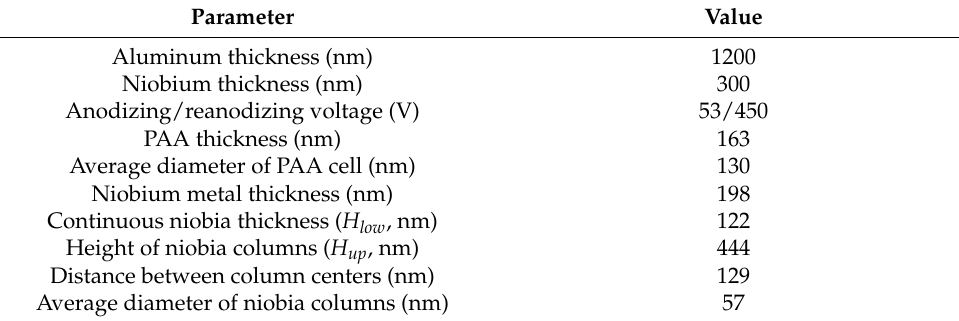
Table 2. Morphological parameters of the first-level nanostructures. Parameter Value Aluminum thickness (nm) 1200 Niobium thickness (nm) 300 Anodizing/reanodizing voltage (V)